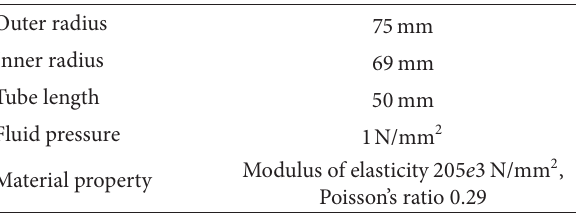
Table 1: Analysis parameter and material.